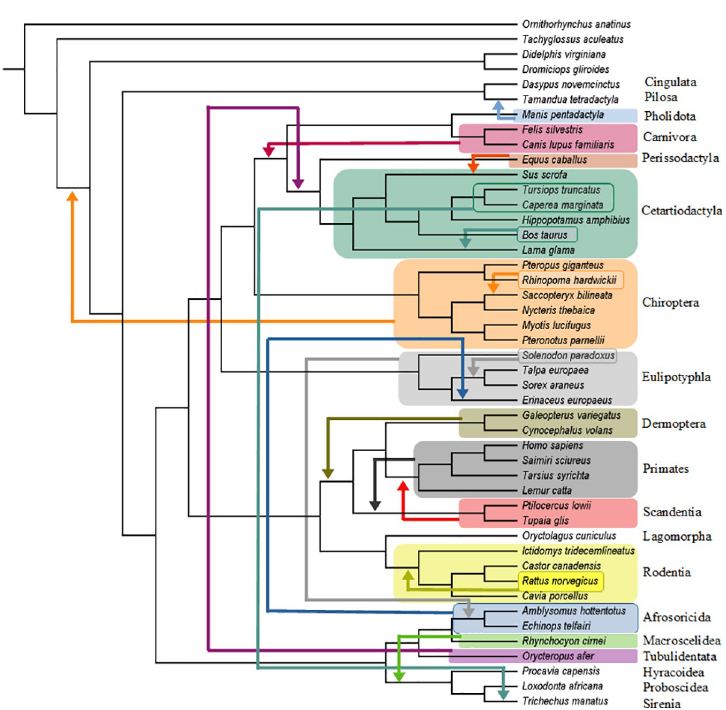
Fig 5. Summary of molecular scaffold + hypothetical predicted ancestors analyses. Summary of the pseudoextinction results for the O’Leary et al. [31] data set for one of our seven sets of analyses (molecular scaffold + hypothetical predicted ancestors). Orders that were recovered in phylogenetic positions that conflict with the molecular scaffold are indicated by arrows. Any shifts of individual species are also indicated by arrows. All analyses recovered a single most parsimonious tree (MPT). Only seven orders (37%) (Proboscidea, Sirenia, Lagomorpha, Hyracoidea, Cingulata, Pilosa, Rodentia) remained in the correct interordinal position when pseudoextinct.